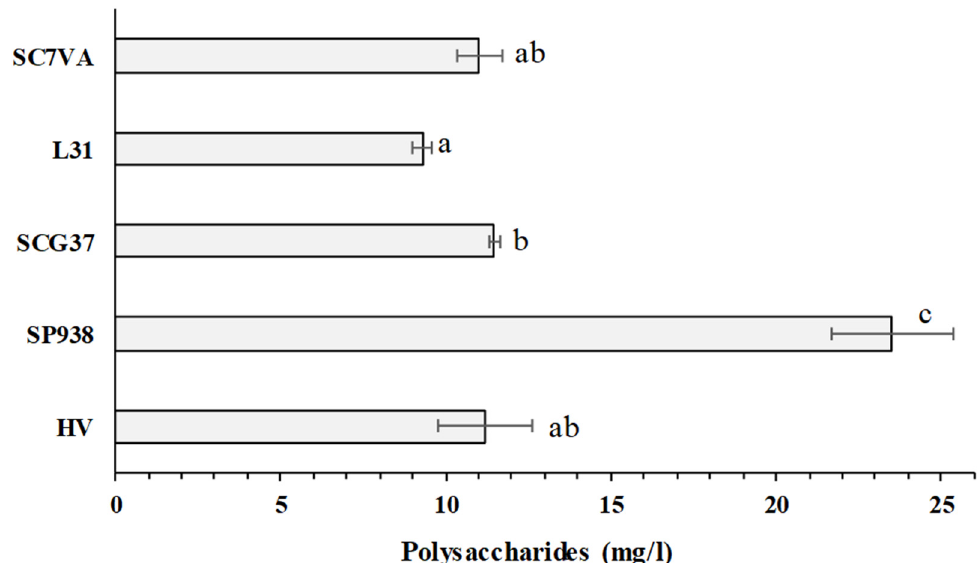
Figure 4. Polysaccharides content (mg/L) after 156 days of ageing on lees in hydroalcoholic solution. HV ( Hanseniaspora vineae ); SP938 ( Schizosaccharomyces pombe 938 strain); SCG37 ( Saccharomyces cerevisiae G37 strain); L31 ( Lachancea thermotolerans L31 strain); SC7VA ( Saccharomyces cerevisiae 7VA strain). Mean ± standard deviation of three replicates. Different letters indicate values with statistically significant differences ( p < 0.05).